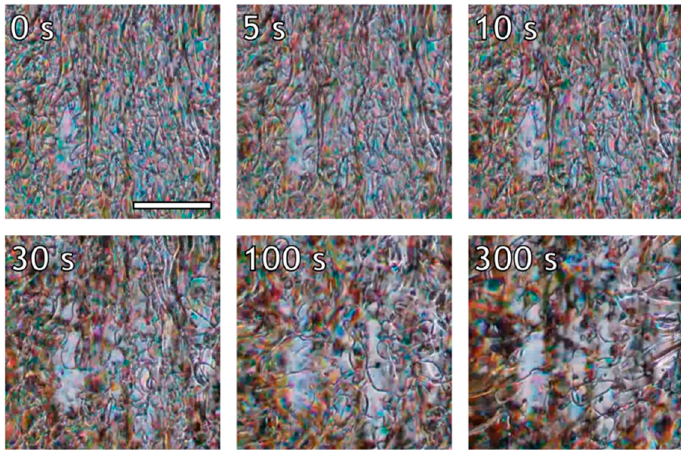
Figure 4. Relaxation from equilibrium texture of the LCP after the application of shear (0.16 s − 1 ) at 200 °C. Flow direction is vertical; the scale bar marks 100 µm and applies to all sub-images.